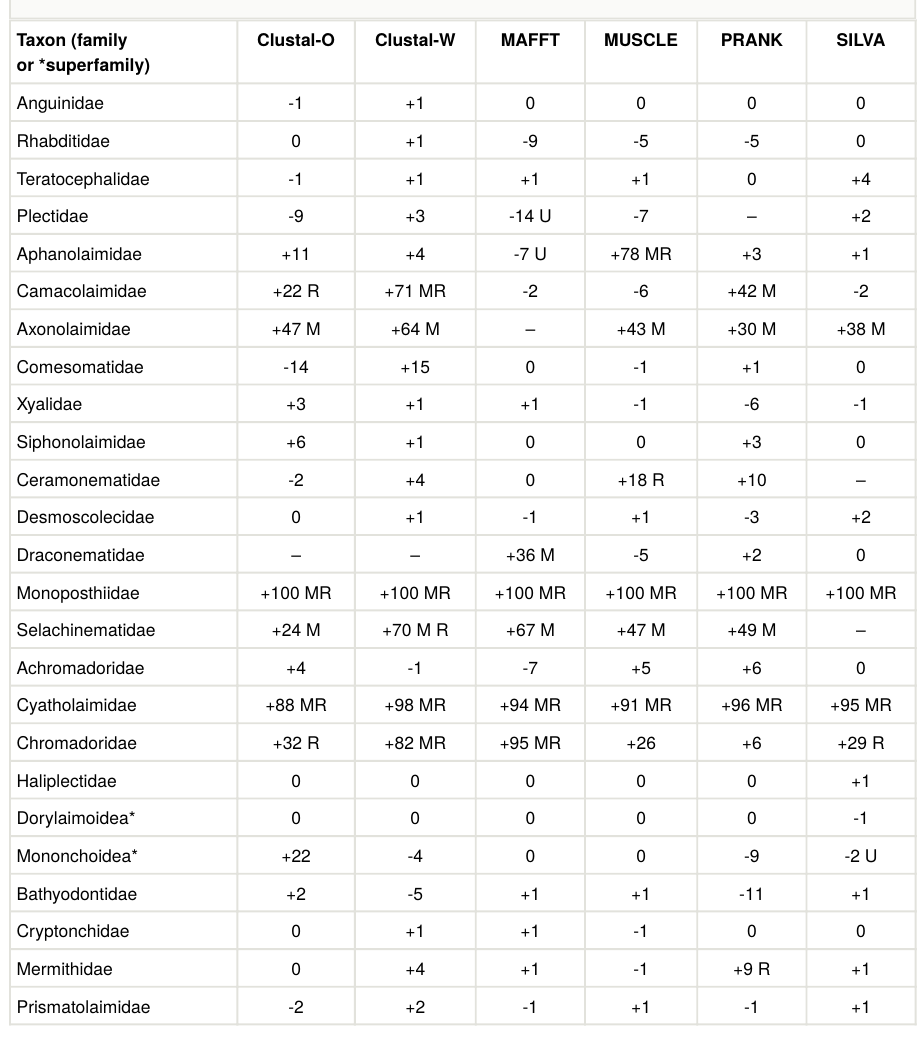
Comparison of changes in bootstrap support (increase or decrease) and resolution for di ff erent nematode families between Maximum likelihood analyses of complete and " fi ltered" datasets. Legend: "M" – clade changed from paraphyletic or polyphyletic to monophyletic; "P" – clade changed from monophyletic to paraphyletic or polyphyletic; "–" – clade remained paraphyletic or polyphyletic; "R" – monophyletic clade became fully resolved (bootstrap increased to ≥ 70%); "U" – monophyletic clade became unresolved (bootstrap decreased to